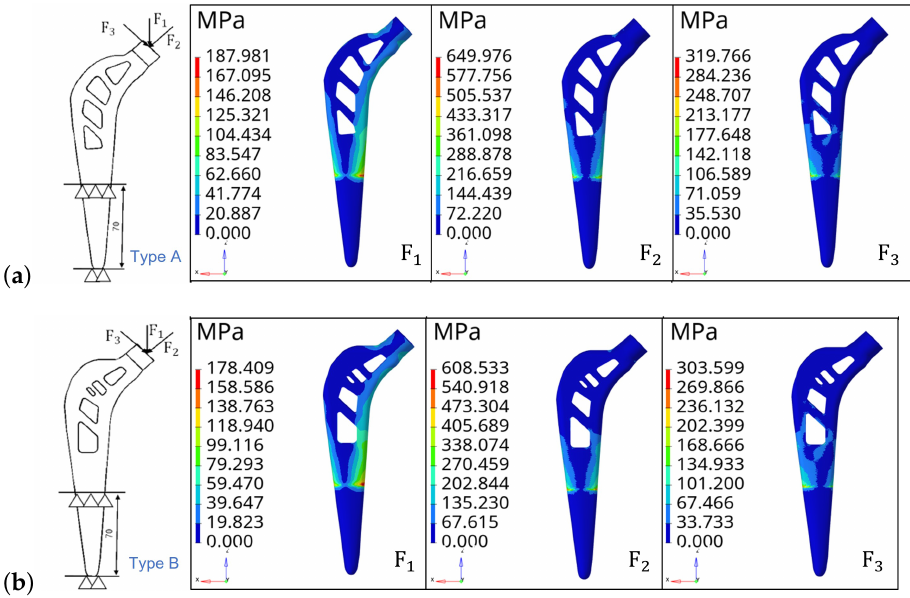
Figure 6. Constraints, vector load force and stress nephogram. ( a ) Type A. ( b ) Type